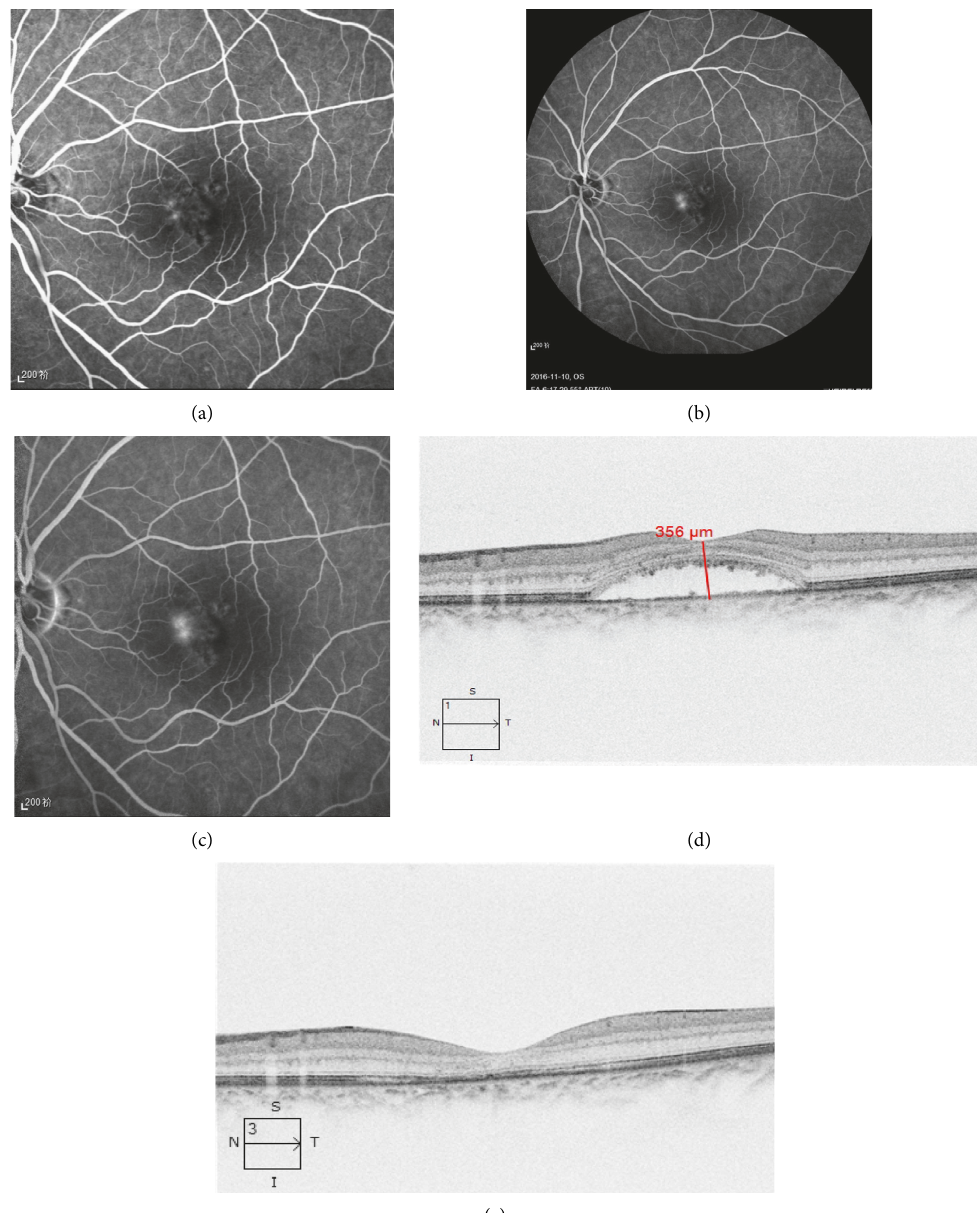
Figure 2: A 50-year-old male patient who underwent half-dose PDT. (a–c) FFA showed left eye macular parafoveal fluorescein leakage and RPE “windows defect” at the early phase stage, and dye formed the link pattern of fluorescein staining in the parafoveal area at the late phase stage. (d) OCT showed the baseline serous macular retinal detachment before half-dose PDT. (e) Macular subretinal fluids completely absorb after treatment follow-up three